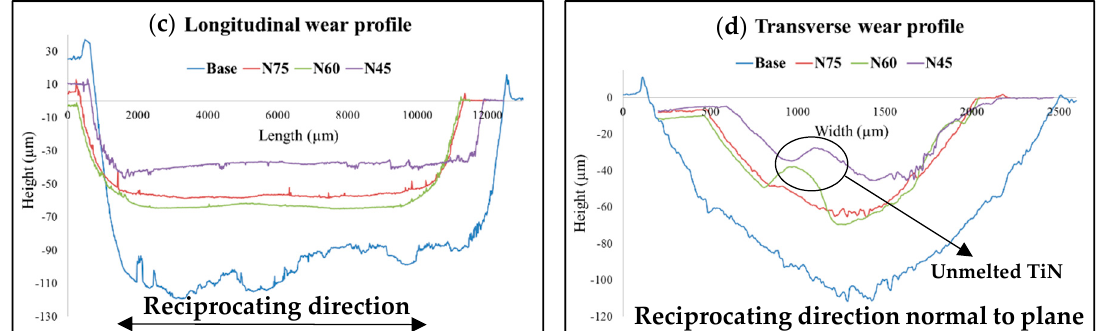
Figure 12. Effect of two-step nitriding-remelting on wear resistance of CP-Ti: ( a ) measured wear scar volumes; ( b ) variation of coefficient of friction over the test duration; wear scar profiles in the ( c ) longitudinal and ( d ) transverse directions. The symbol NX in the figures denotes “nitrided at X mm/s speed” i.e., higher the number X , lower the nitrogen content and hardness of the nitrided layer. Reprinted with permission from Ref. [112]. Copyright 2017 Elsevier.